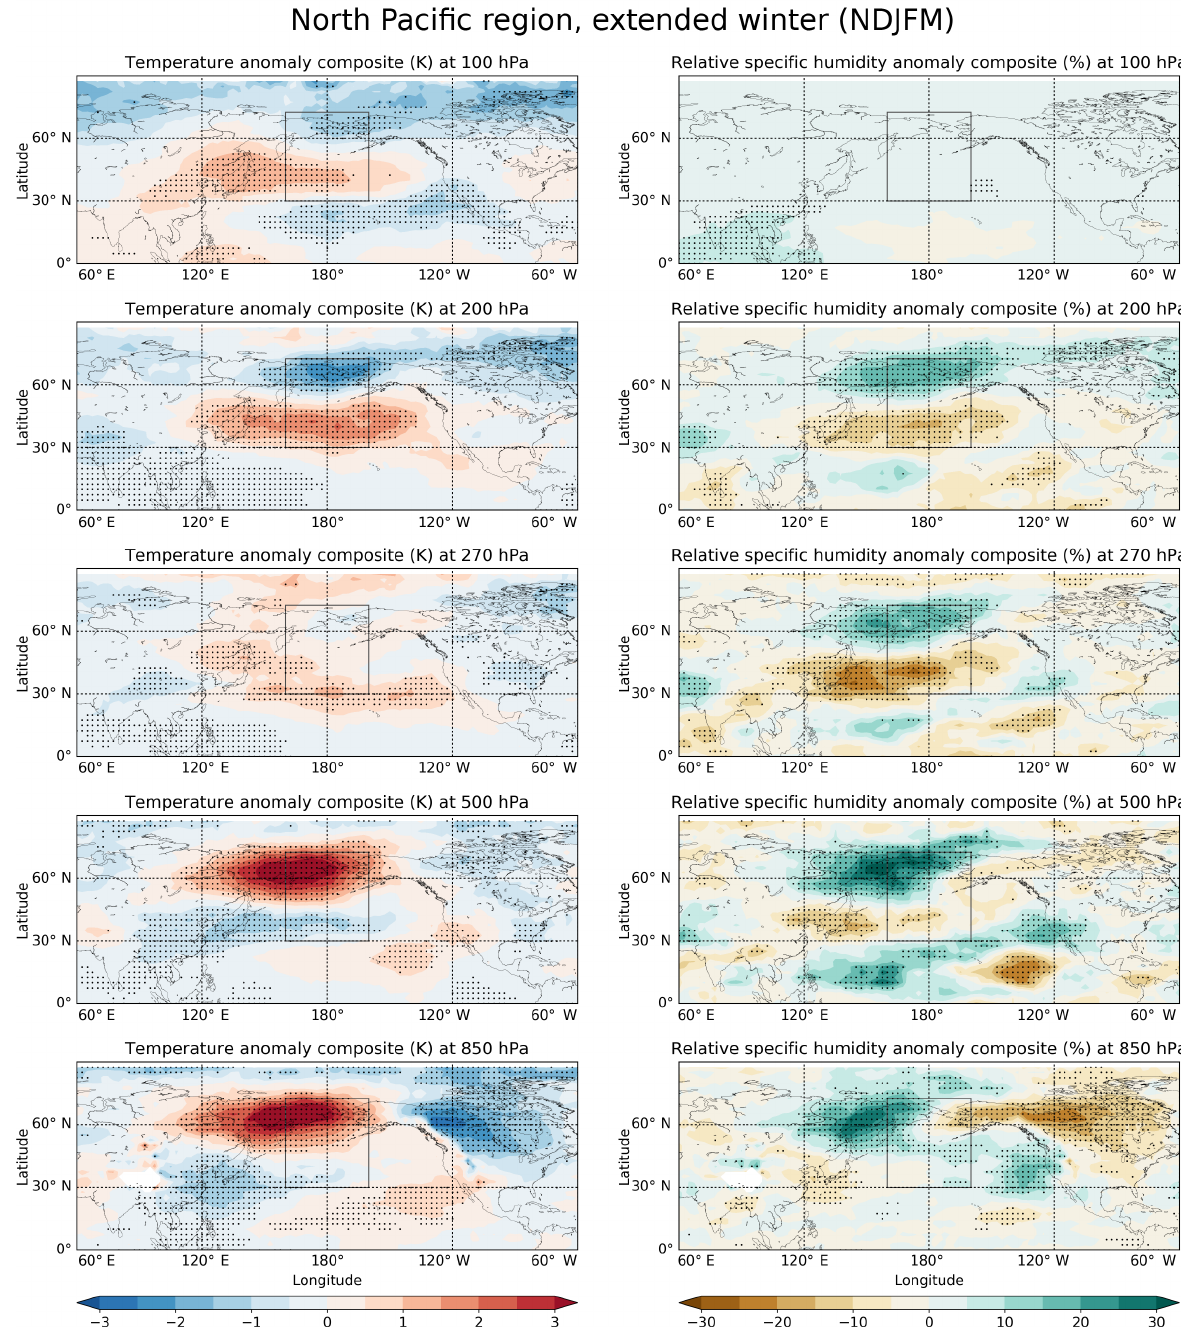
Figure 7. As Fig. 5 but for blocking in the North Pacific region between 160 ◦ E–160 ◦ W and 30–72.5 ◦ N (191 days in total).